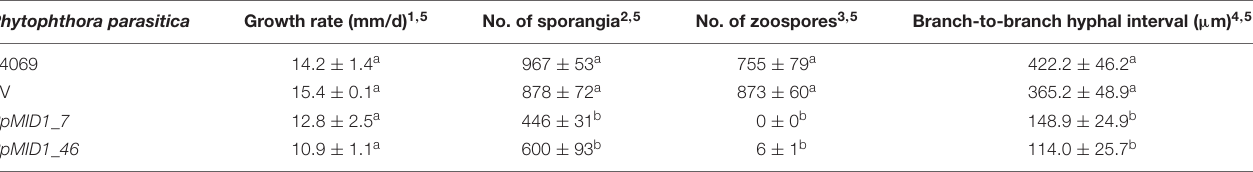
TABLE 1 | PpMID1- silenced transformants produce less sporangia and branch more frequently. Phytophthora